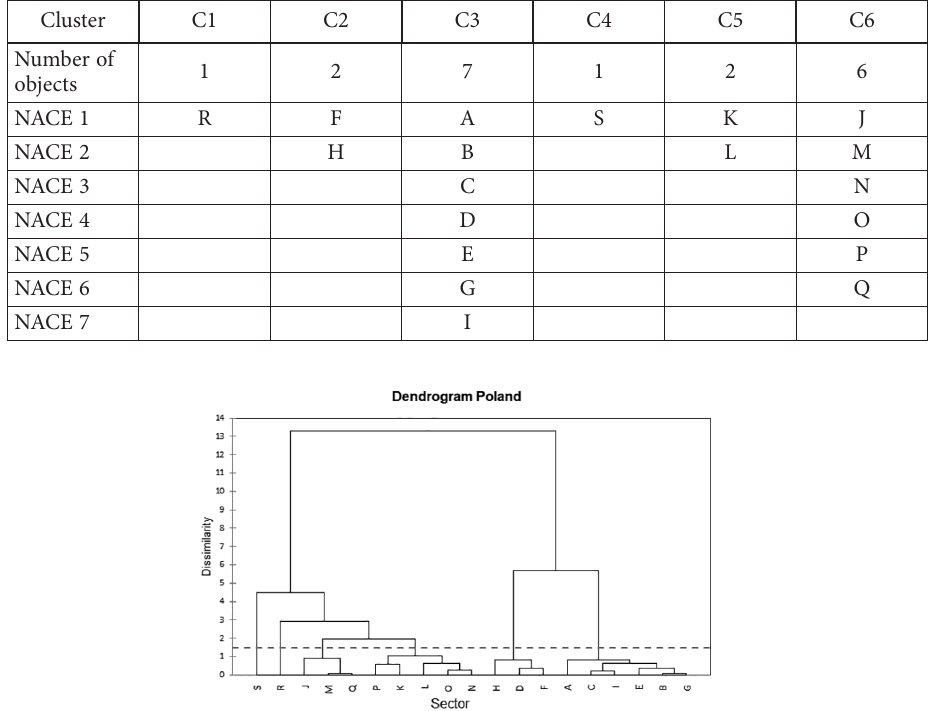
Figure 4. Dendrogram Poland (source: